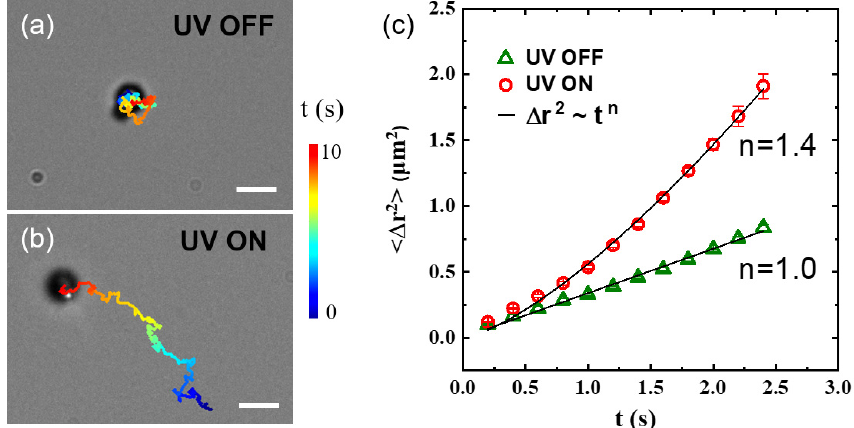
Figure 3. ( a , b ) Trajectories of PS–AgCl hybrid dimer active colloids in water upon turning the UV light ( a ) off and ( b ) on. The total time, shown color-coded, is 10 s. Scale bars: 2 µ m. ( c ) Mean squared displacements as a function of lag time for the particles in ( a , b ). Solid lines are power-law fittings, with n = 1 indicating Brownian motion for a diffusive microparticle, and n = 1.4 > 1 indicating the super-di ff usive motion of active colloid. The error bars represent standard deviations.